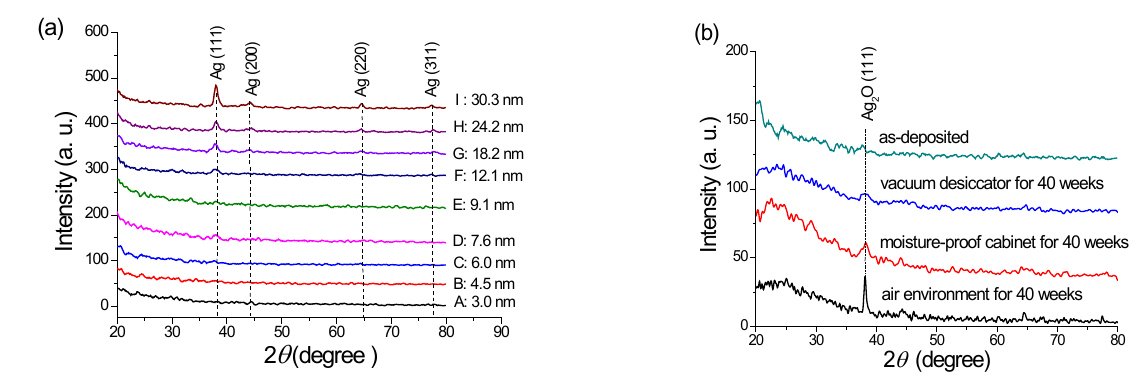
Figure 5. ( a ) The XRD patterns of the AgNP layers (the as-deposited Sample A to I) with various thicknesses. ( b ) The XRD measurements of Sample C from the as-deposited, stored in a moisture- proof cabinet, vacuum desiccator, and air environment for up to forty weeks.